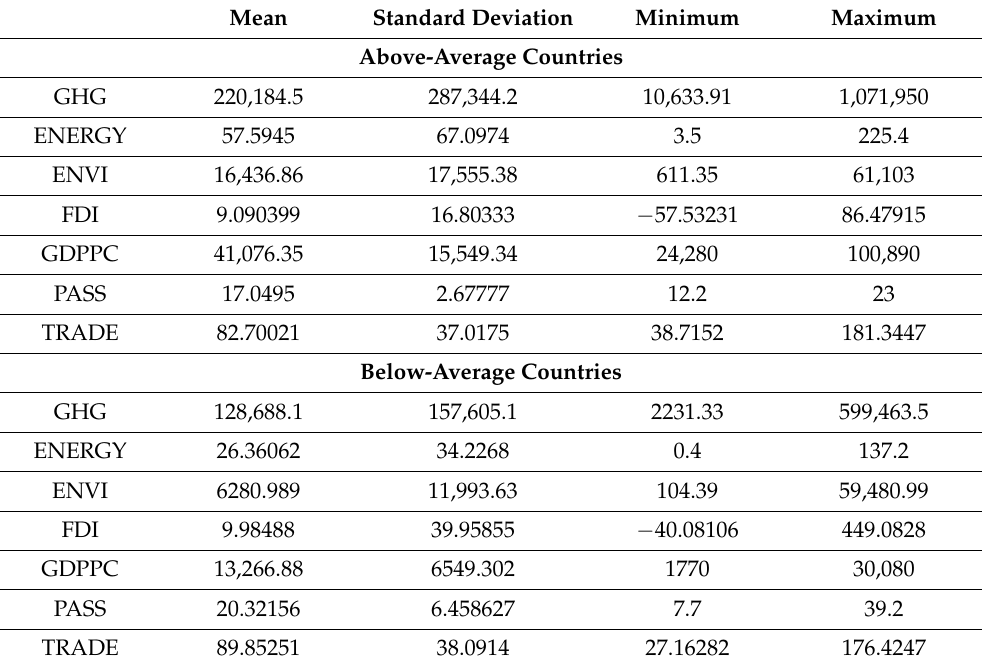
Table 3. Descriptive statistics. Source: